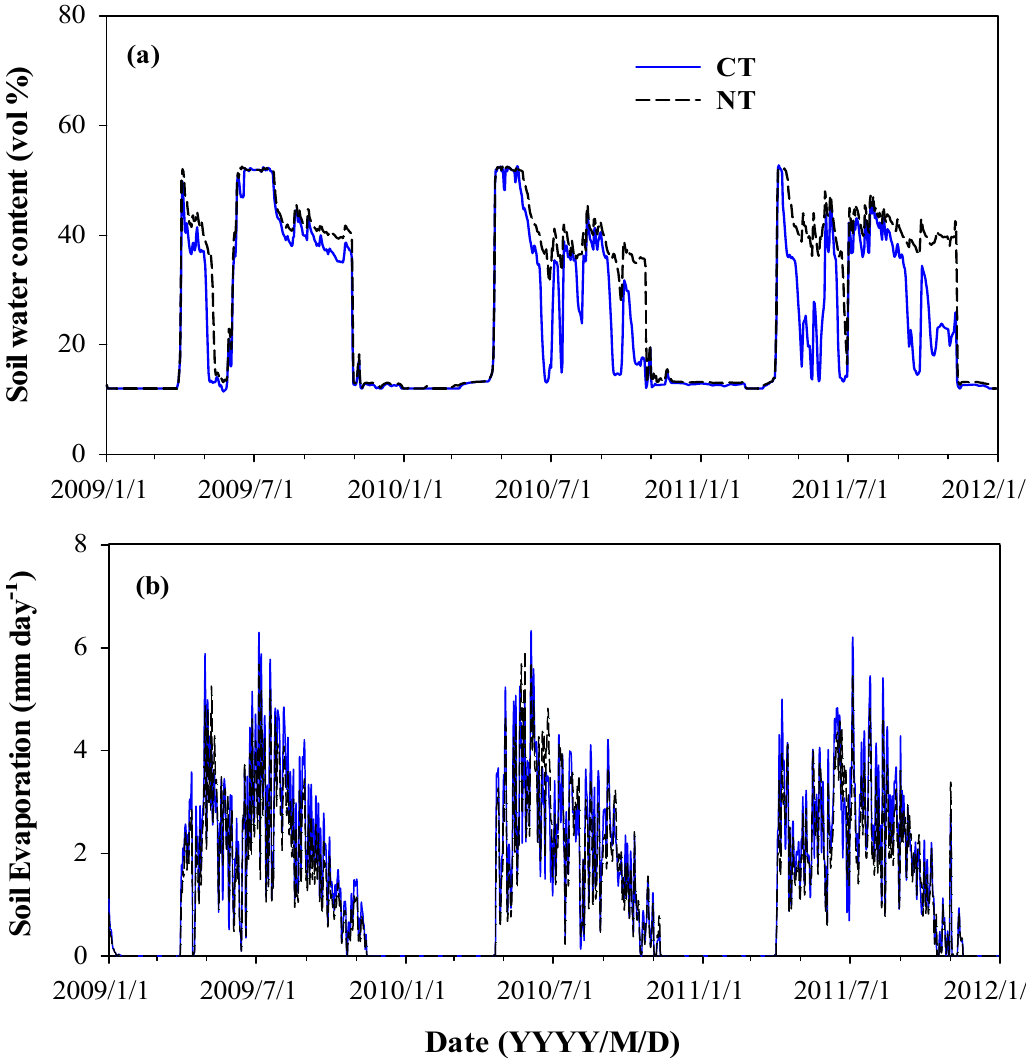
Figure 7. Simulated ( a ) daily average soil water contents at 0–10 cm depth and ( b ) daily soil evaporation for CT and NT during 2009–2011.